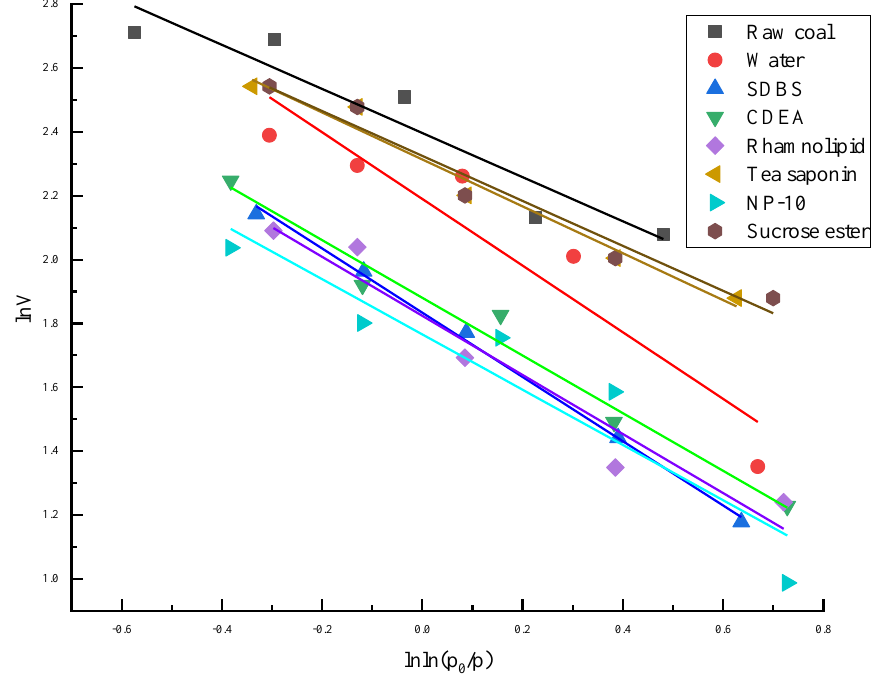
Figure 9. Fractal dimension fitting curve of raw coal and modified coal microscopic